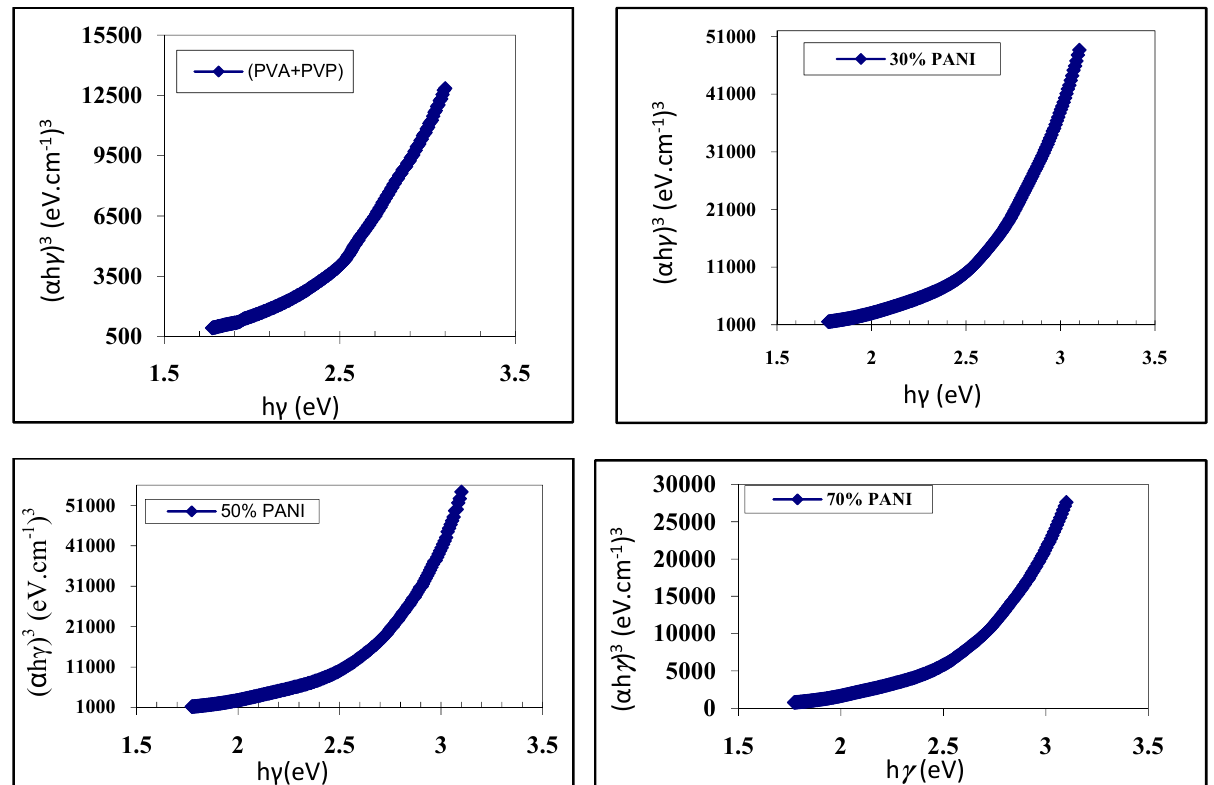
Fig. 4: The ( α h γ ) 3 vs. (h γ ) for (PVA-PVP)+PANI blends polymer prepared with different PNAI per-centage as an additive